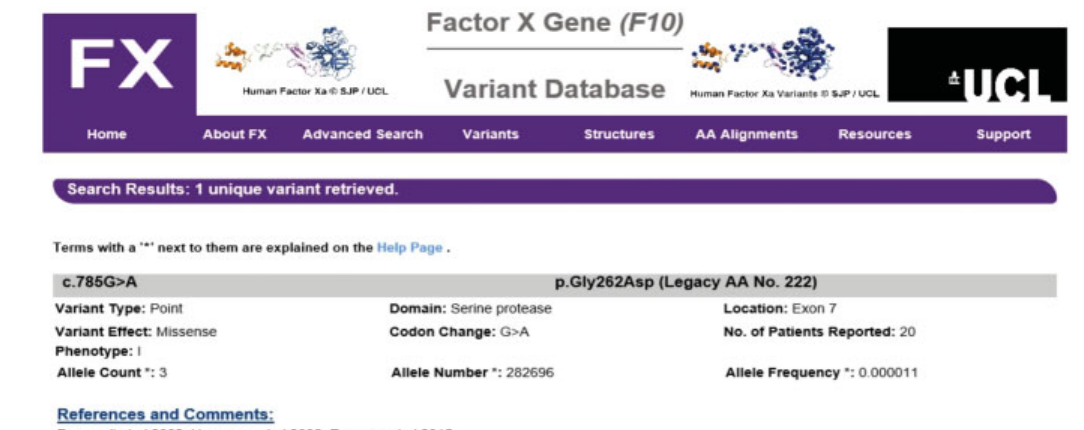
Fig. 2 Screenshots of the new factor X (FX) interactive web database to illustrate the genetic and structural analysis made for the Gly262Asp variant. The upper panel displays the output when residue 262 is inputted on the FX web site home page. By clicking “ Show ” next to the patient information heading, the lower left panel lists genetic information for the 20 patients reported with the Gly262Asp variant, of which the fi rst 12 records are visible here, together with the source of the patient record. The multiple sequence alignment is shown underneath with Gly262 highlighted by a red arrow. Clicking “ HERE ” under the structural interpretation heading gives the image shown on the bottom right panel. This assesses the buried or exposed accessibility of the variant and its location in the FXa protein structure. Four different substitution analyses (the Grantham, PolyPhen-2, the Sorting Intolerant From Tolerant [SIFT], and PROVEAN) are provided to help predict the likely effects of each missense variant on FXa. A JMol view of the FXa structure is displayed that can be rotated and zoomed into as desired. Additional information regarding the amino acid side chain properties of both the wild type and mutant residues is also displayed on this page.